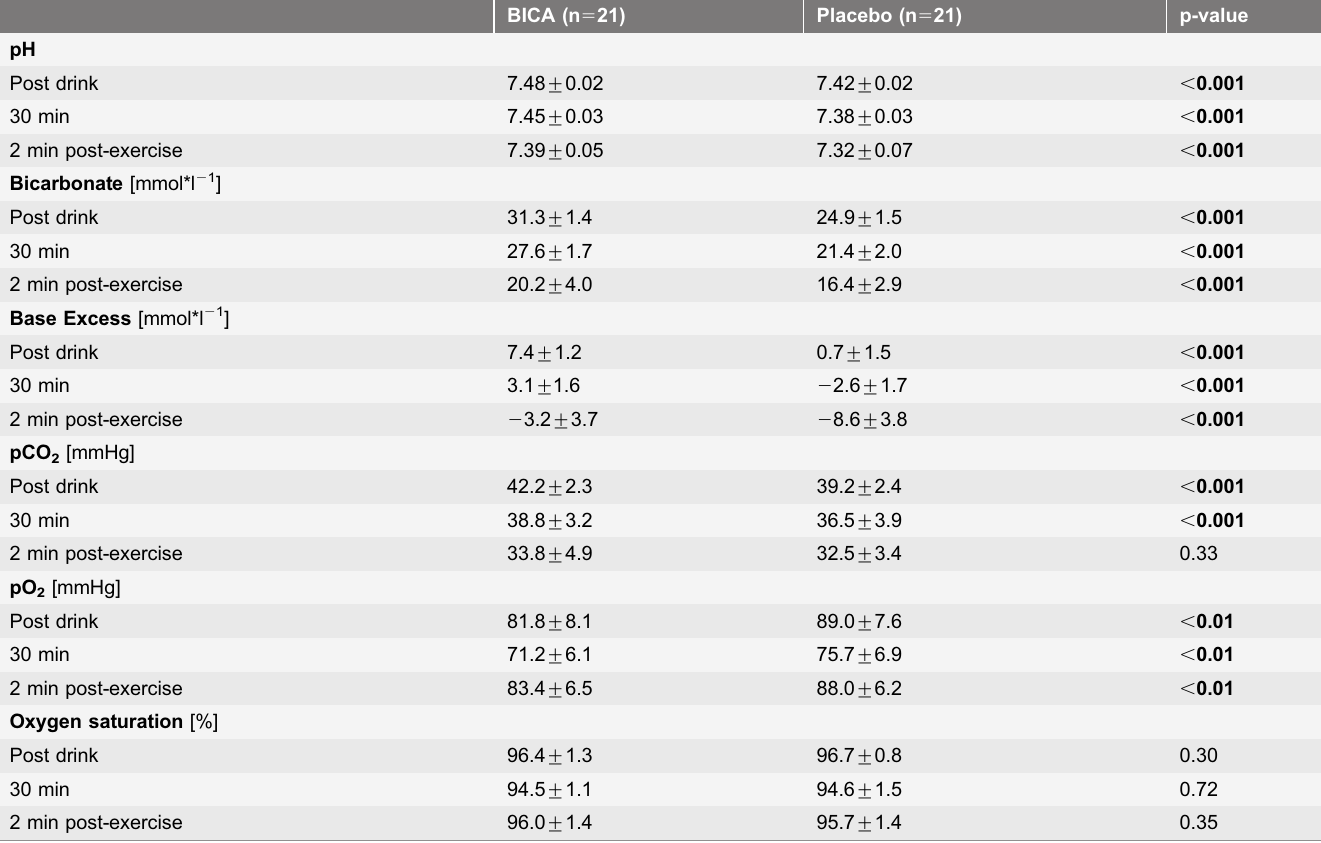
Table 1. Blood gas parameters during constant load